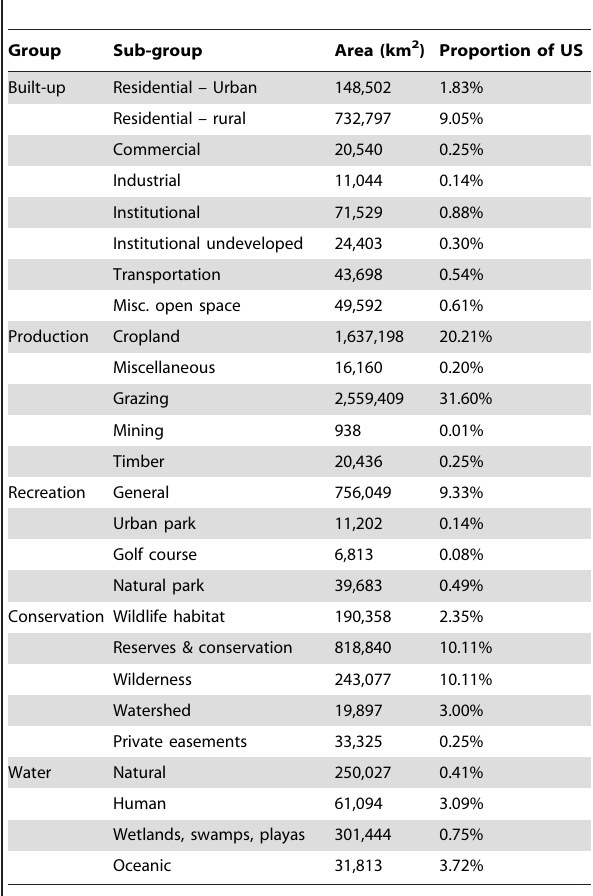
Table 3. Area and proportion of the US for sub-group level of the National Land Use dataset